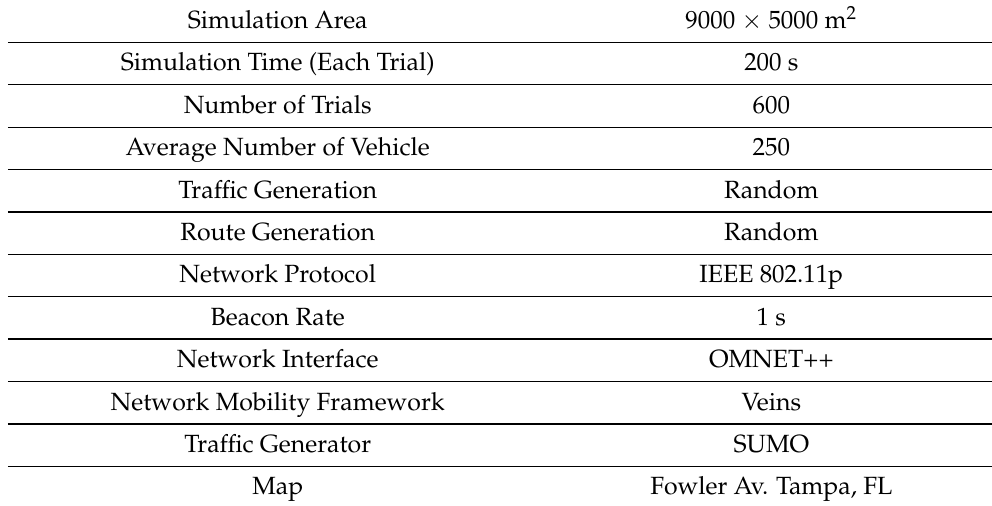
Figure 8. Simulation map showing Fowler Ave. Table 1. Simulation